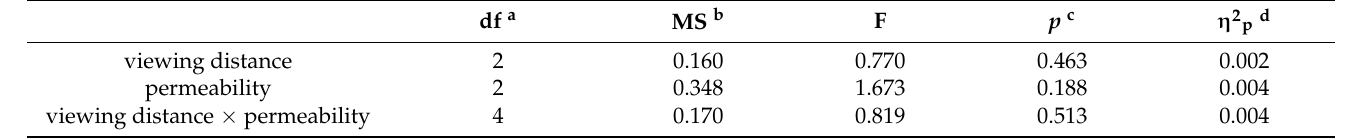
Table 8. Impacts of different viewing distances and permeability levels on (cid:52) E RMSSD. df a MS b p c